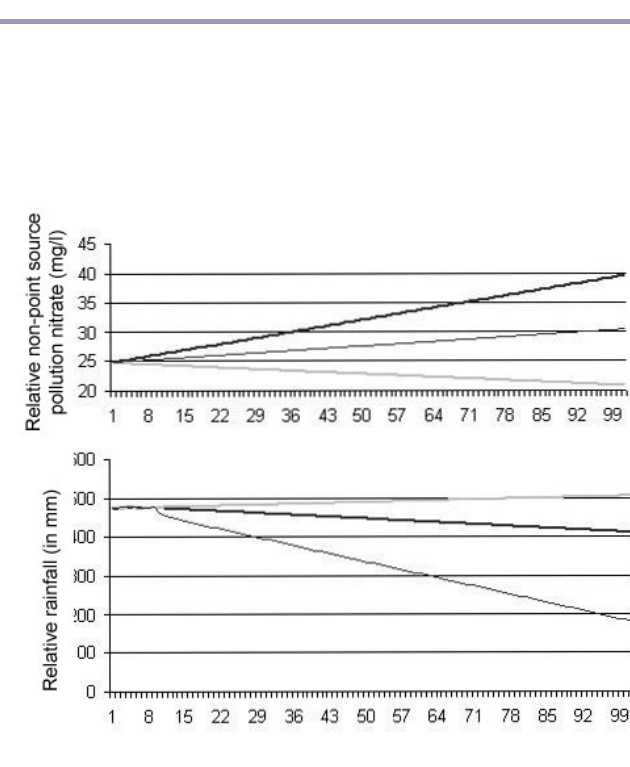
Fig. 9 . Scenarios (S1, S2, and